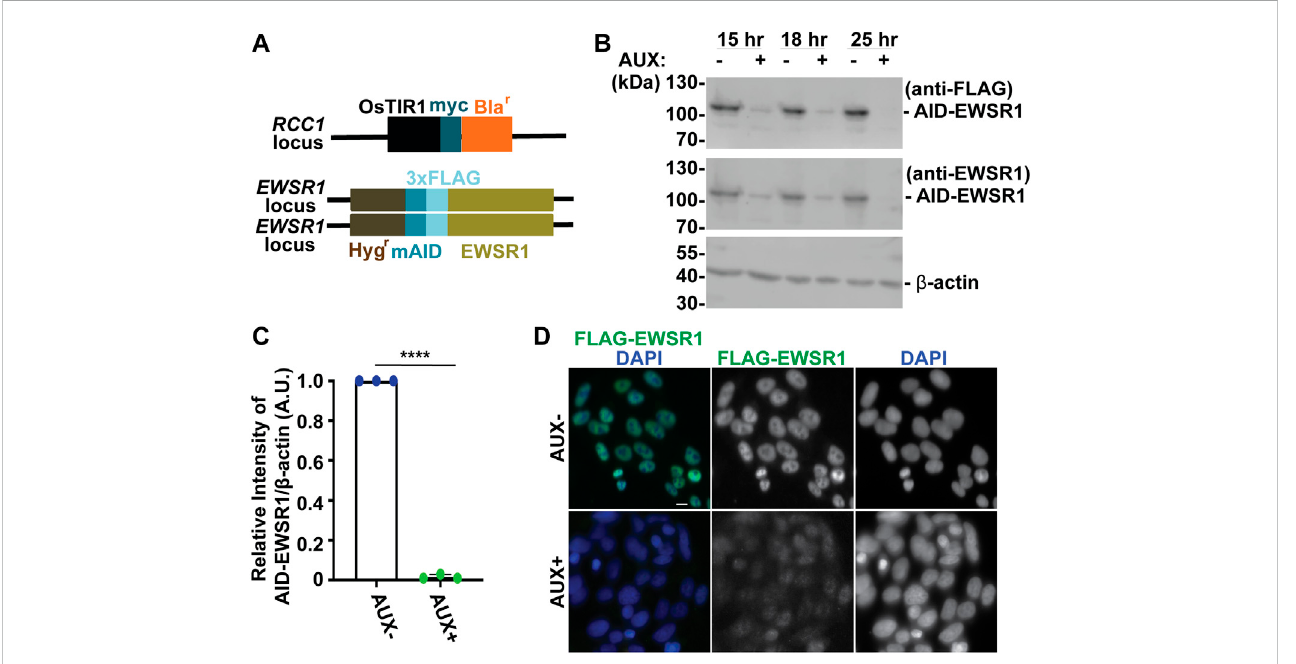
FIGURE 1 The treatment of a stable AID-EWSR1/AID-EWSR1 DLD-1 cell line with Auxin induces an ef fi cient degradation of AID-EWS. (A) . Schematic diagram of OsTIR1 and AID-EWSR1 DNAconstruct. OsTIR1 :plantdrivenE3ligase, Bla r :Blasticidineresistancegene, Hyg r :Hygromycinresistancegene, mAID :miniAuxin- Inducible Degron tag, 3XFLAG ; three tandem repeat of FLAG tag. The OsTIR1 construct was inserted at the RCC1 locus, and mAID construct was inserted to both EWSR1 loci (homozygous). (B) . Representative images of western blotting using anti-FLAG (top panel), anti-EWSR1 (middle panel) and anti- β actin (bottom panel) obtained from AUX- and AUX + cells in the presence of Auxin at given time point (15 h, 18 h and 25 h). (C) . Relative intensity of the bands of westernblottingvisualizedwithanti-EWSR1(normalizedtothebandswithanti- β -actin)obtainedfromAUX-andAUX+cells( n =3experiments).Graphshows the mean of each group with Standard Deviation (SD). ( n = 3 experiments). **** p < 0.0001 (Two tailed paired t -test). (D) . Representative images of immunocytochemistry using anti-FLAG (green) and DAPI (blue) obtained from AUX- and AUX + cells. Scale bar = 10 um.